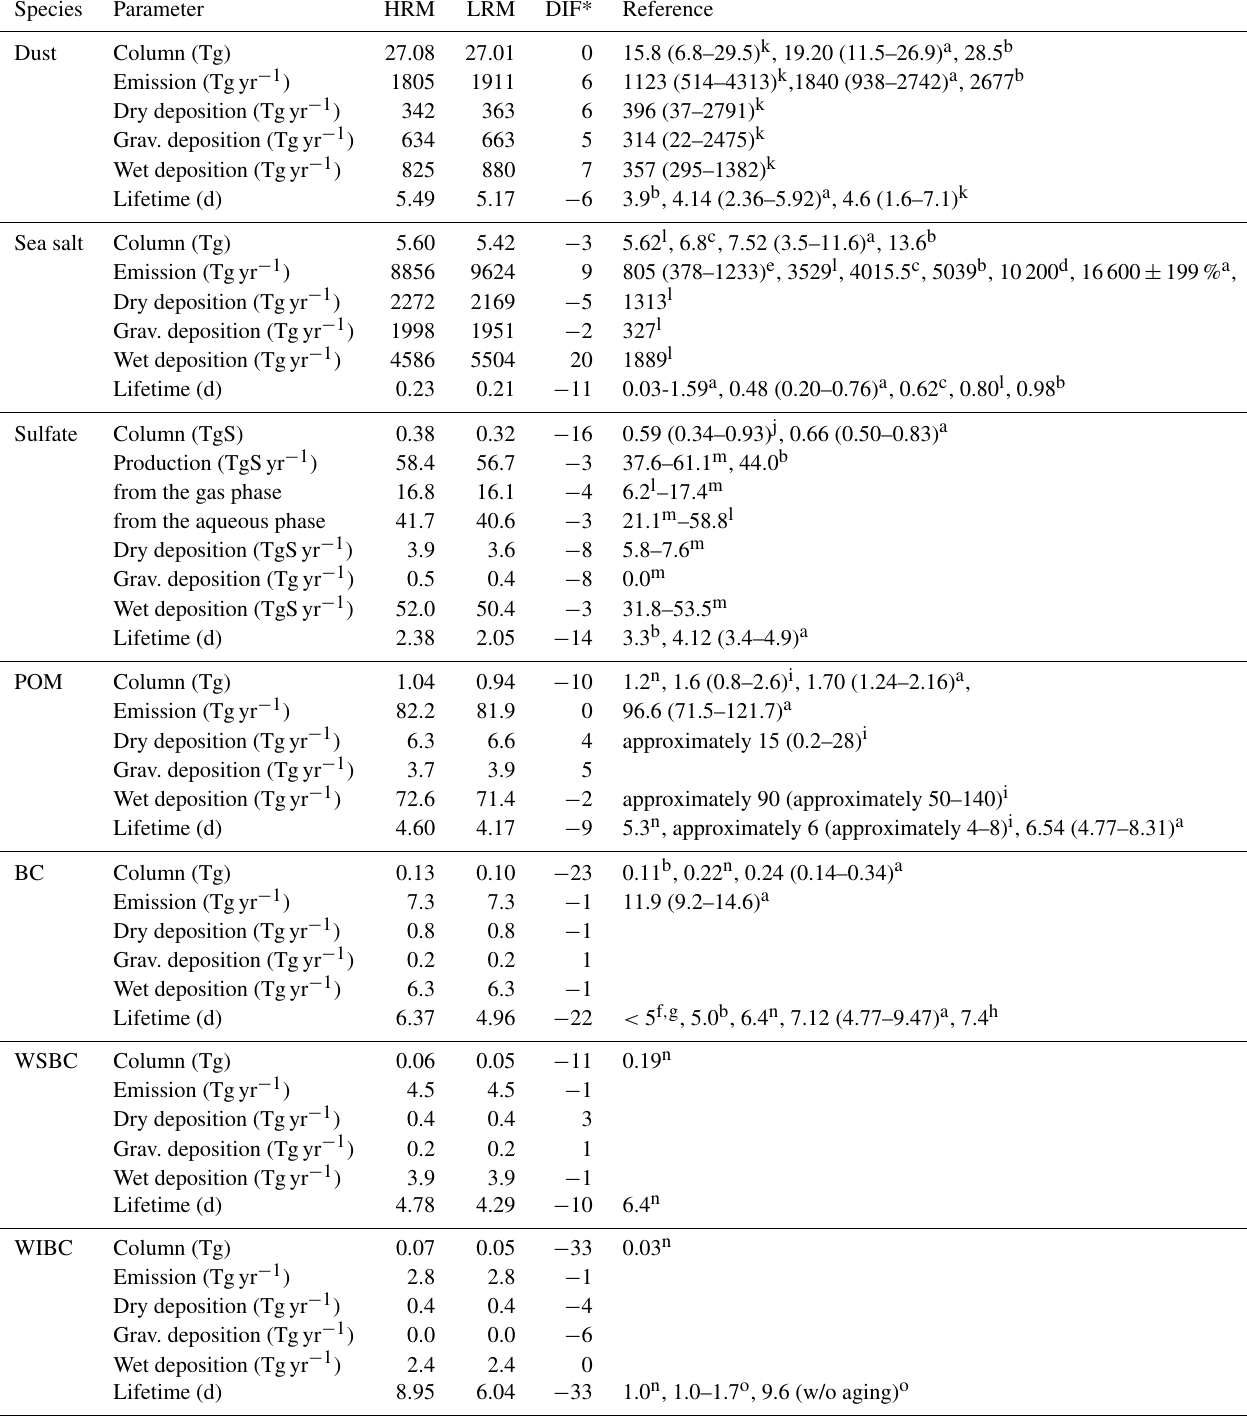
Table 2. Global aerosol budgets simulated by the HRM and LRM.